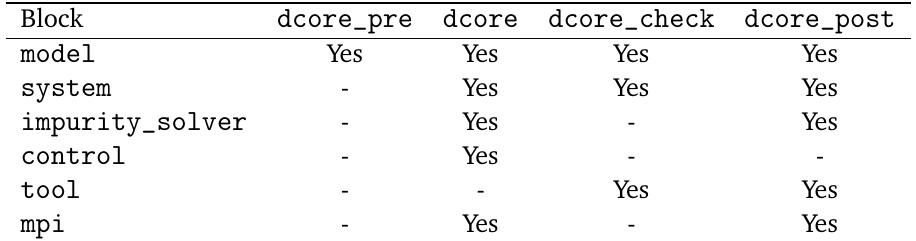
Table 1: Blocks to be used for each program in DCore.